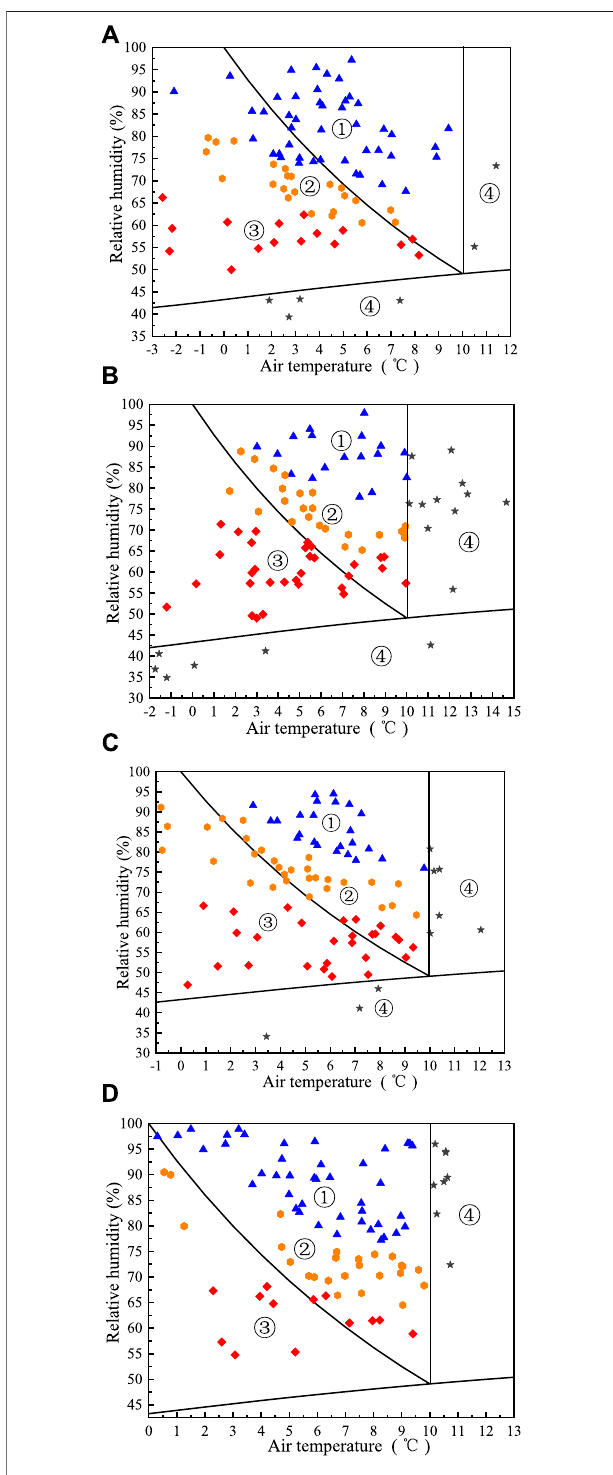
FIGURE 8 | Classi fi cation of the frosting degree in Nanjing, Shanghai, Wuhan, Changsha, Chongqing, Xi ’ an, and Beijing in the temperature – humidity diagram and Harbin in the three-phase diagram: (A) Nanjing; (B) Shanghai; (C) Wuhan; (D) Changsha; (E) Chongqing; (F) Xi ’ an; (G) Beijing; and (H)